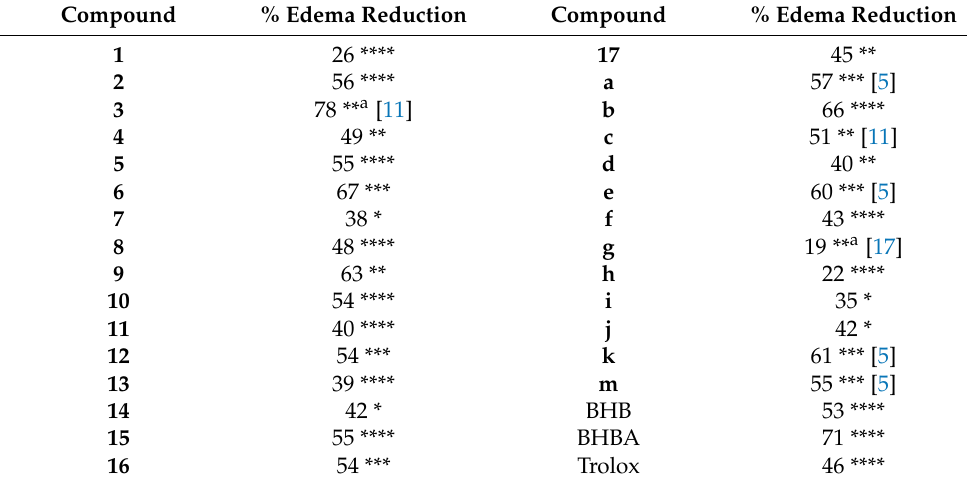
Table 2. Effect of compounds 1–17 and parent NSAIDs (or corresponding alcohol derivatives) on carrageenan-induced mouse paw